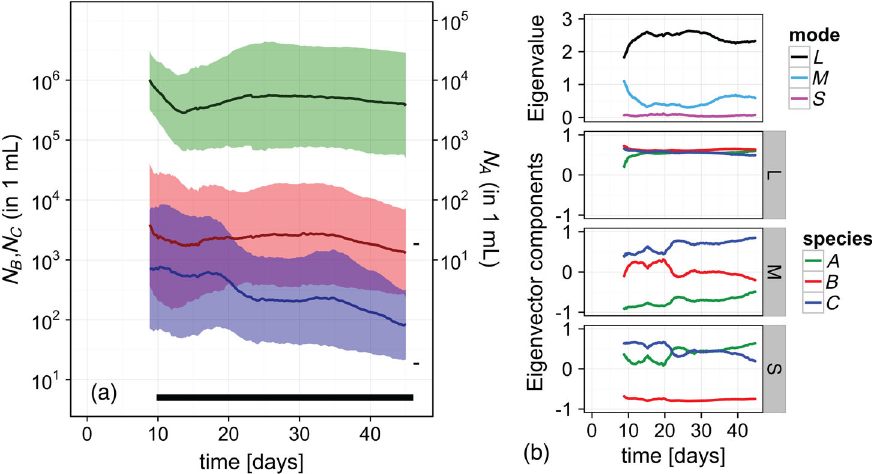
FIG. 5. Structure of fluctuations across ecosystems in a range of conditions. (a) Population dynamics, as in Fig. 1(d), for 63 replicate ecosystems maintained at 7 illumination conditions between I ¼ 0 . 2 I 0 and I ¼ I 0 . The geometric mean (bold curves) and standard deviation (shaded regions) are computed across all 63 replicates and 7 illumination conditions. Data before 9 days are missing in some conditions because of overly high cell abundance. (b) Dynamics of the correlation matrix: The correlation matrix C ð t Þ of logarithmic abundances of the three species was calculated for the data shown in (a). The eigenvalues of C ð t Þ were sorted by size and are plotted as time series in the top panel: L (large, black line); M (medium, cyan line); S (small, magenta line). The composition of the corresponding eigenvectors is plotted in the bottom three panels. Green: C. reinhardtii ( A ), red: E. coli ( B ), blue: T. thermophila ( C